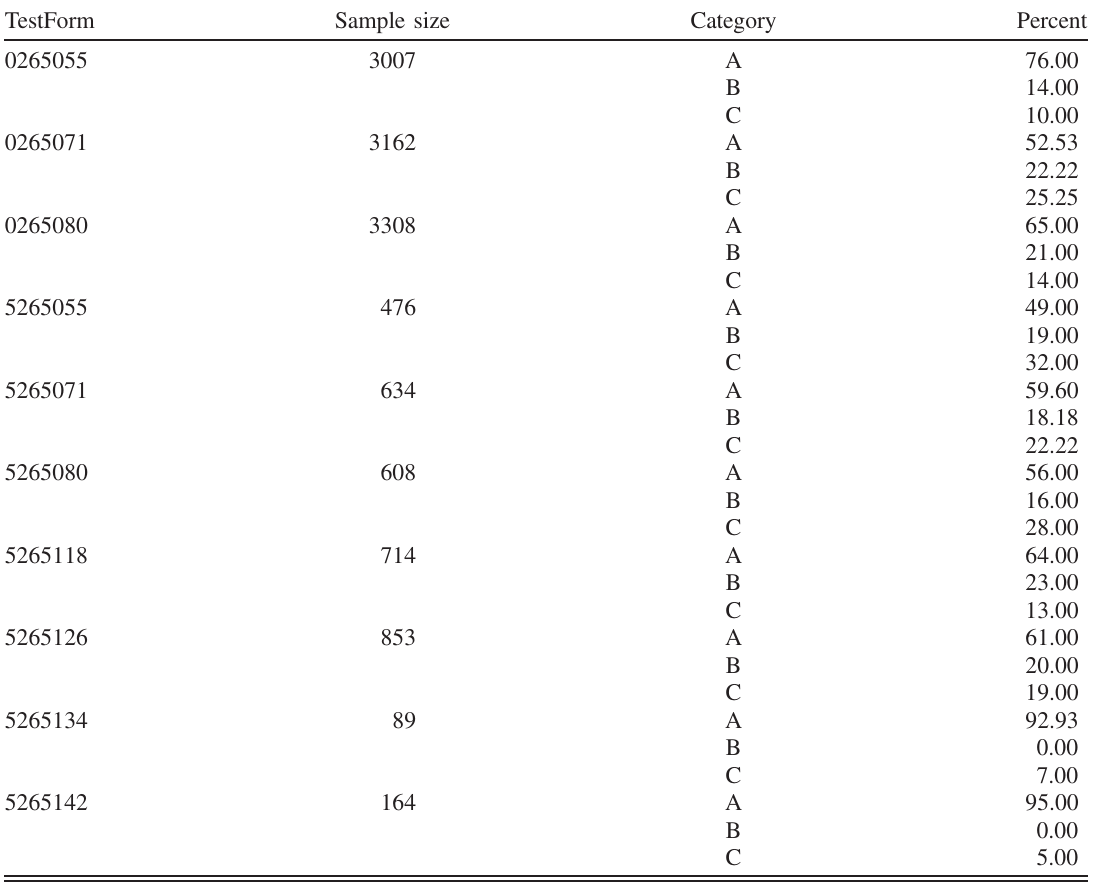
TABLE V. Gender differential item functioning analysis of Praxis physics subject assessments test forms from 2006 to 2016. Item categories (ABC) were determined using form-specific scores for males (reference group) and females (focal